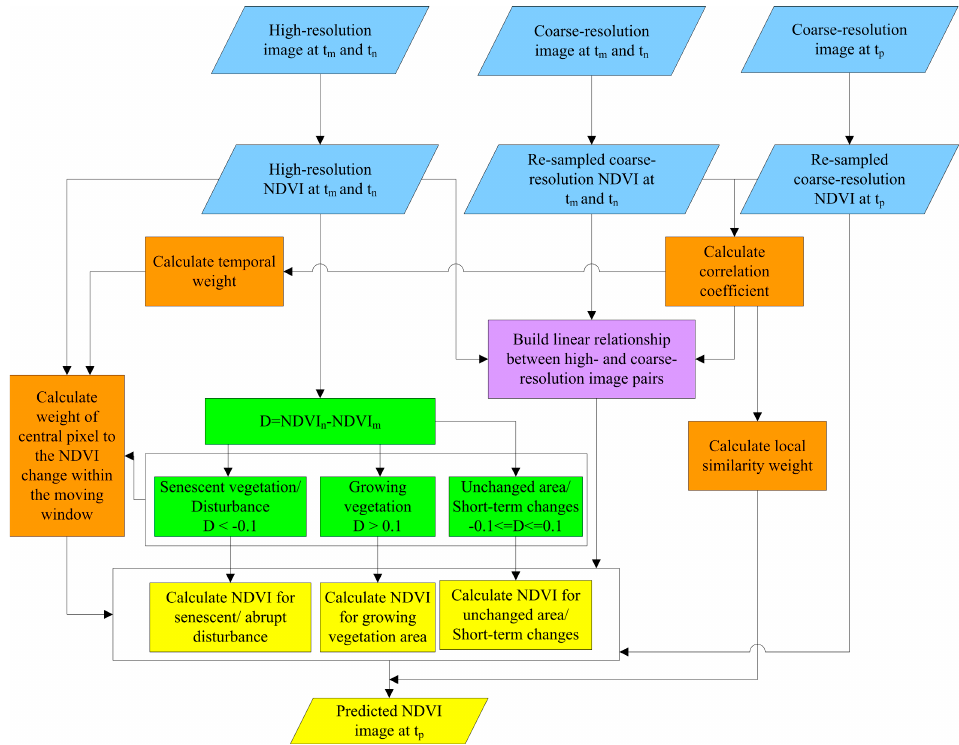
Figure 2. Flowchart of the spatio-temporal vegetation index image fusion model (STVIFM) algorithm. The steps are shaded by different colors ( blue : satellite data preprocessing; green : NDVI change detection; orange : weight calculation; purple : coefficients determination; yellow : NDVI prediction).